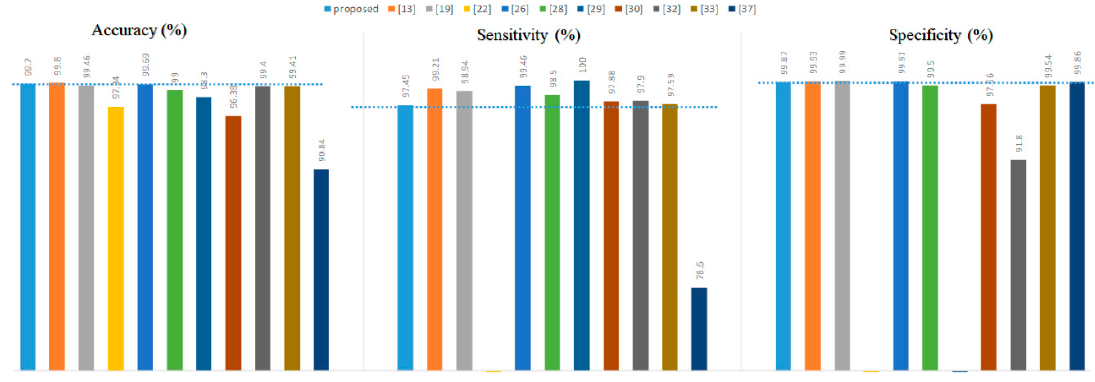
Figure 8. Comparison with other literature.